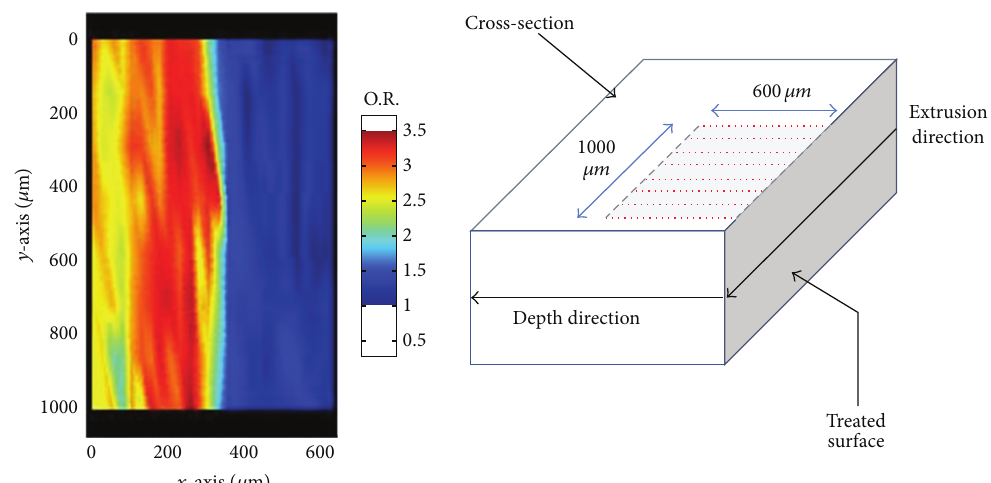
Figure 5: Mapping of orientation for a 600 × 1000 𝜇 m area as marked by the shaded area with red dots representing the spectral collection